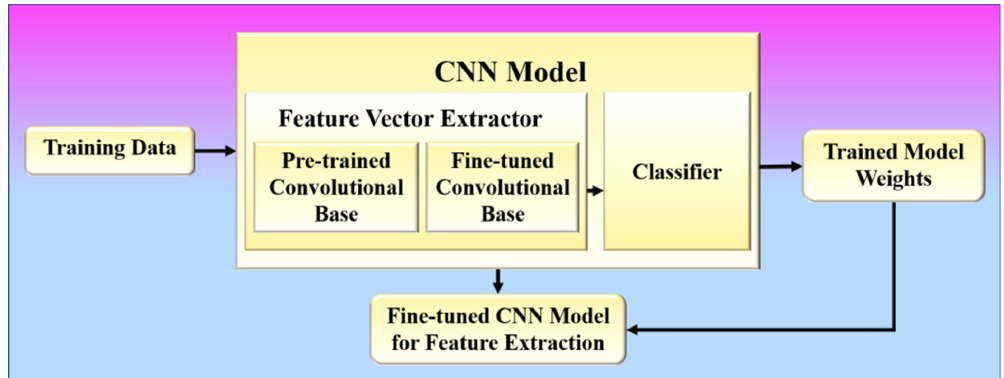
Figure 9. Phase-1 of the proposed system.